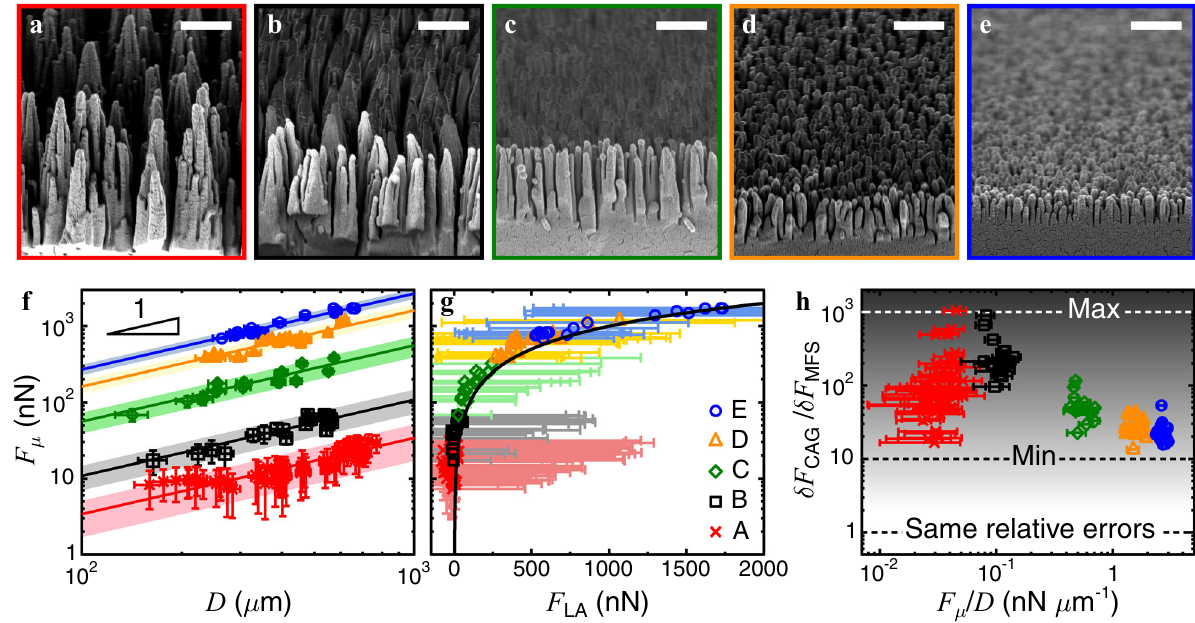
Fig. 3 Friction force on superhydrophobic etched silicon substrates — experiment vs. theory. a – e Scanning electron microscopy images taken at a 45 (cid:2) angle of the A (spikes), B, C, D, and E (grass) samples, respectively. Scale bars 1 μ m. f Measured kinetic friction force as a function of contact region diameter. The solid lines are linear fi ts (through origin) to the data with the slopes F μ = D ¼ ð 2 : 7 ± 0 : 4 Þ ; ð 1 : 6 ± 0 : 3 Þ ; ð 0 : 6 ± 0 : 2 Þ ; ð 0 : 11 ± 0 : 04 Þ ; ð 0 : 03 ± 0 : 02 Þ nN μ m − 1 for the E (grass), D, C, B, and A (spikes) samples, respectively. g Measured friction force as a function of the theoretically calculated lateral adhesion force ( F LA , Eq. (1)). The solid line (going though origin) has a slope of unity. h The ratio between the relative errors ( δ F ¼ Δ F = F , where Δ F is the absolute error) of the theoretical (CAG) and experimental (MFS) force estimates as a function of F μ = D . Measuring the friction force with MFS renders from 10 (min) to 1000 (max) times more precise results as the surface becomes more slippery. As the lower limit of the micropipette technique is approached for small droplets on the most slippery spikes (A) surface (red crosses), the relative error still remains more than 10 times lower when using MFS instead of Eq. (1). The legend in g also applies to the markers in f and h . The error bars in all graphs are standard deviations or error propagations including these (see Supplementary Note 2).